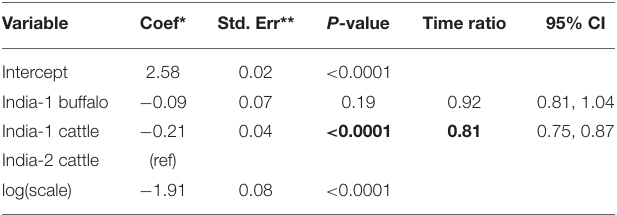
TABLE 5 | Generalized linear mixed model for the probability of FMDV RNA recovery from oropharyngeal fluid following an FMD outbreak in India.